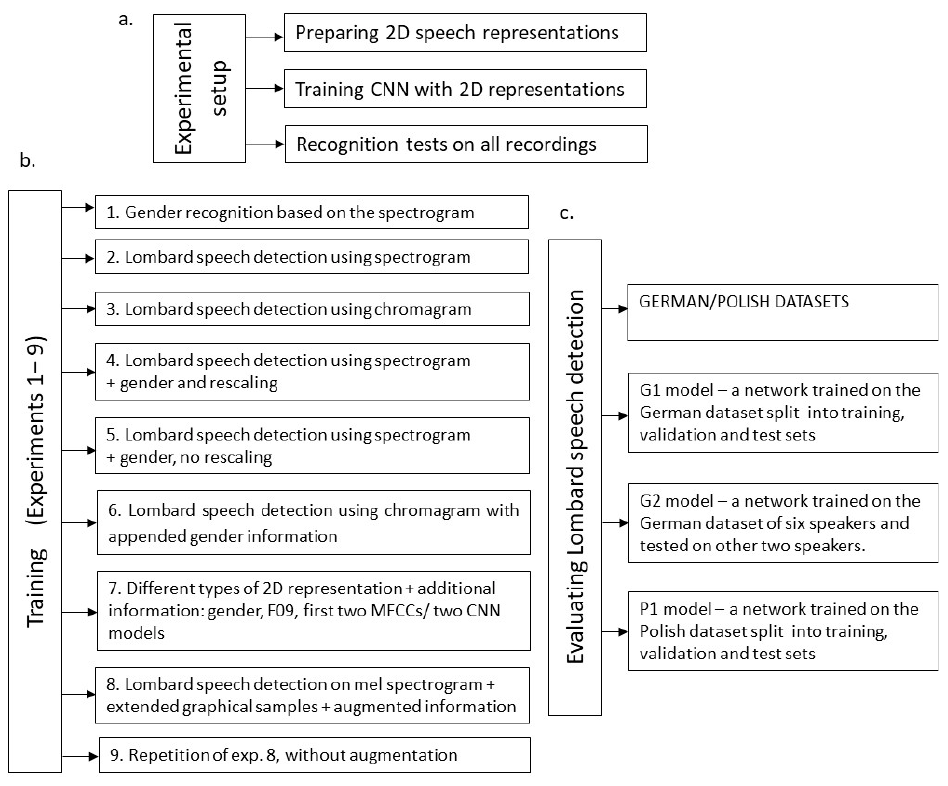
Figure 5. Experimental setup: ( a ) overall experiment design, ( b ) various configurations of 2D feature space representation augmented by additional information combined with CNN models and datasets employed in training, ( c ) evaluation stages.